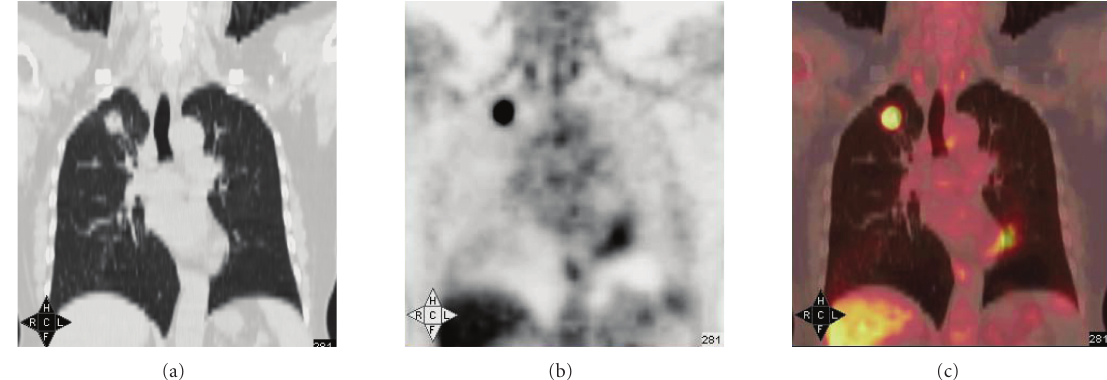
Figure 3: (a), (b), and (c) were from the same patient. The pathological diagnosis is right upper pulmonary squamous carcinoma. There were typical manifestations on CT, PET, and integrated PET/CT. The mass on CT is 2 . 4 cm × 2 . 5cm. The SUVmax of early PET imaging is 7.8.